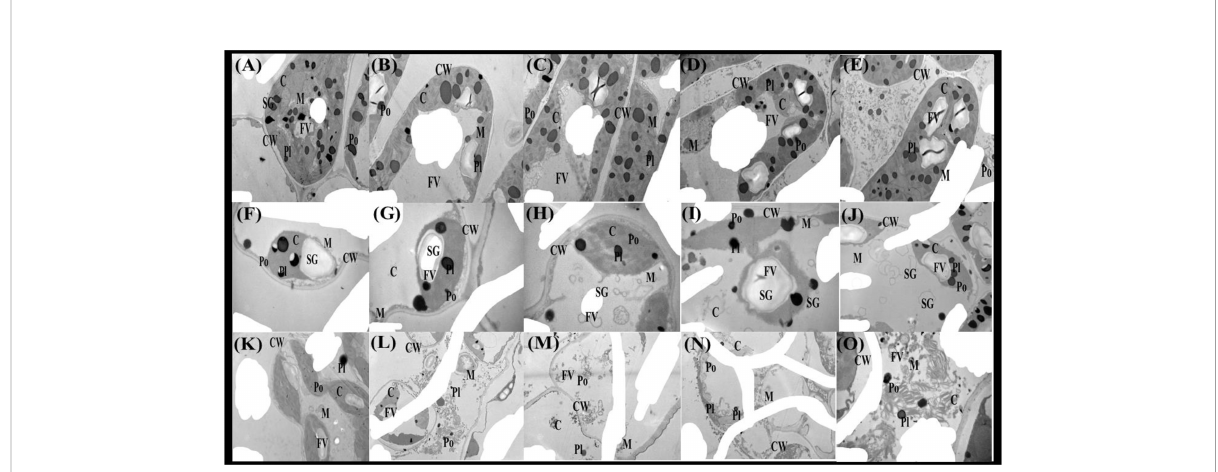
FIGURE 9 Transmission electron microscopy (TEM) photos of Ajwain ( Trachyspermum ammi seedlings) grown under various stress levels of As (i.e., 0 m M, 50 m M, and 100 m M). Different lowercase abbreviations in the TEM photos are presented as: C, chloroplast; CW, cell wall; M, mitochondria; FV, food vacuole; SG, starch grain; Po, peroxisome; and Pl, plastoglobuli. Different uppercase abbreviations are used for the various treatments of iron oxide nanoparticles (FeO-NPs) (i.e., 50 mg/l − 1 and 100 mg/l − 1 ) and plant growth-promoting bacteria [ Providencia vermicola ( P. vermicola )] (i.e., 5 ppm and 10 ppm) grown under various stress levels of As (i.e., 0 m M, 50 m M, and 100 m M). For example: (A) FeO-NPs 0 mg/l − 1 , P. vermicola 0 ppm, and As concentration 0 m M; (B) FeO-NPs 50 mg/l − 1 , P. vermicola 0 ppm, and As concentration 0 m M; (C) FeO-NPs 100 mg/ l − 1 , P. vermicola 0 ppm, and As concentration 0 m M; (D) FeO-NPs 0 mg/l − 1 , P. vermicola 5 ppm, and As concentration 0 m M; (E) FeO-NPs 0 mg/ l − 1 , P. vermicola 10 ppm, and As concentration 0 m M; (F) FeO-NPs 0 mg/l − 1 , P. vermicola 0 ppm, and As concentration 50 m M; (G) FeO-NPs 50 mg/l − 1 , P. vermicola 0 ppm, and As concentration 50 m M; (H) FeO-NPs 100 mg/l − 1 , P. vermicola 0 ppm, and As concentration 50 m M; (I) FeO- NPs 0 mg/l − 1 , P. vermicola 5 ppm, and As concentration 50 m M; (J) FeO-NPs 0 mg/l − 1 , P. vermicola 10 ppm, and As concentration 50 m M; (K) FeO-NPs 0 mg/l − 1 , P. vermicola 0 ppm, and As concentration 100 m M; (L) FeO-NPs 50 mg/l − 1 , P. vermicola 0 ppm, and As concentration 100 m M; (M) FeO-NPs 100 mg/l − 1 , P. vermicola 0 ppm, and As concentration 100 m M; (N) FeO-NPs 0 mg/l − 1 , P. vermicola 5 ppm, and As